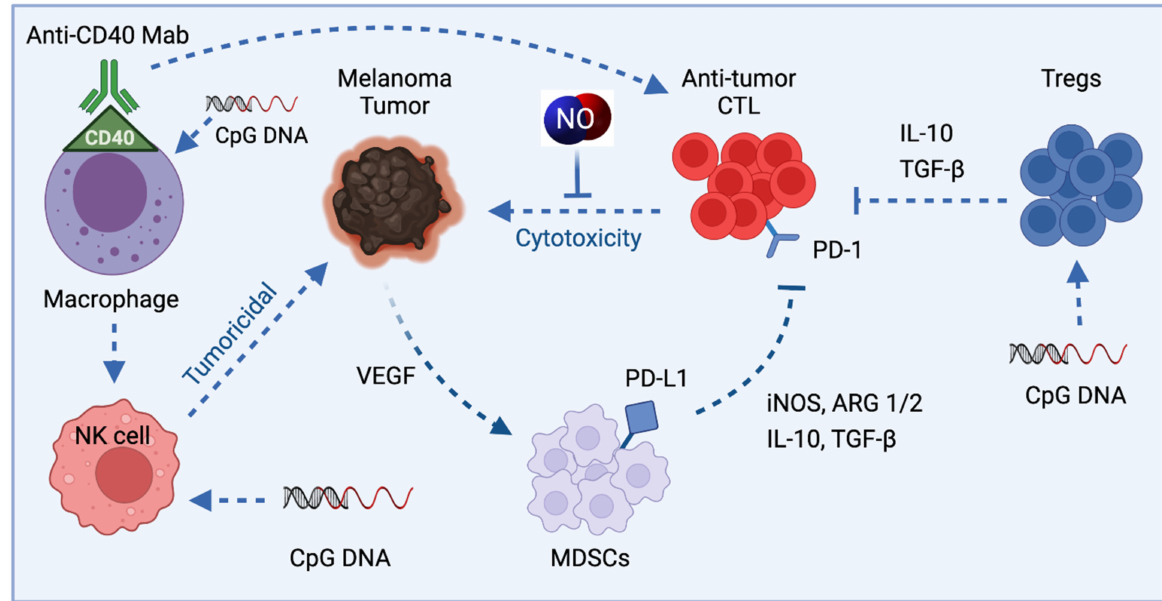
Figure 4. NO in melanoma tumor-induced immune suppression. Treatments such as CD40 activation and CpG may activate macrophages, produce NO and reduce immune